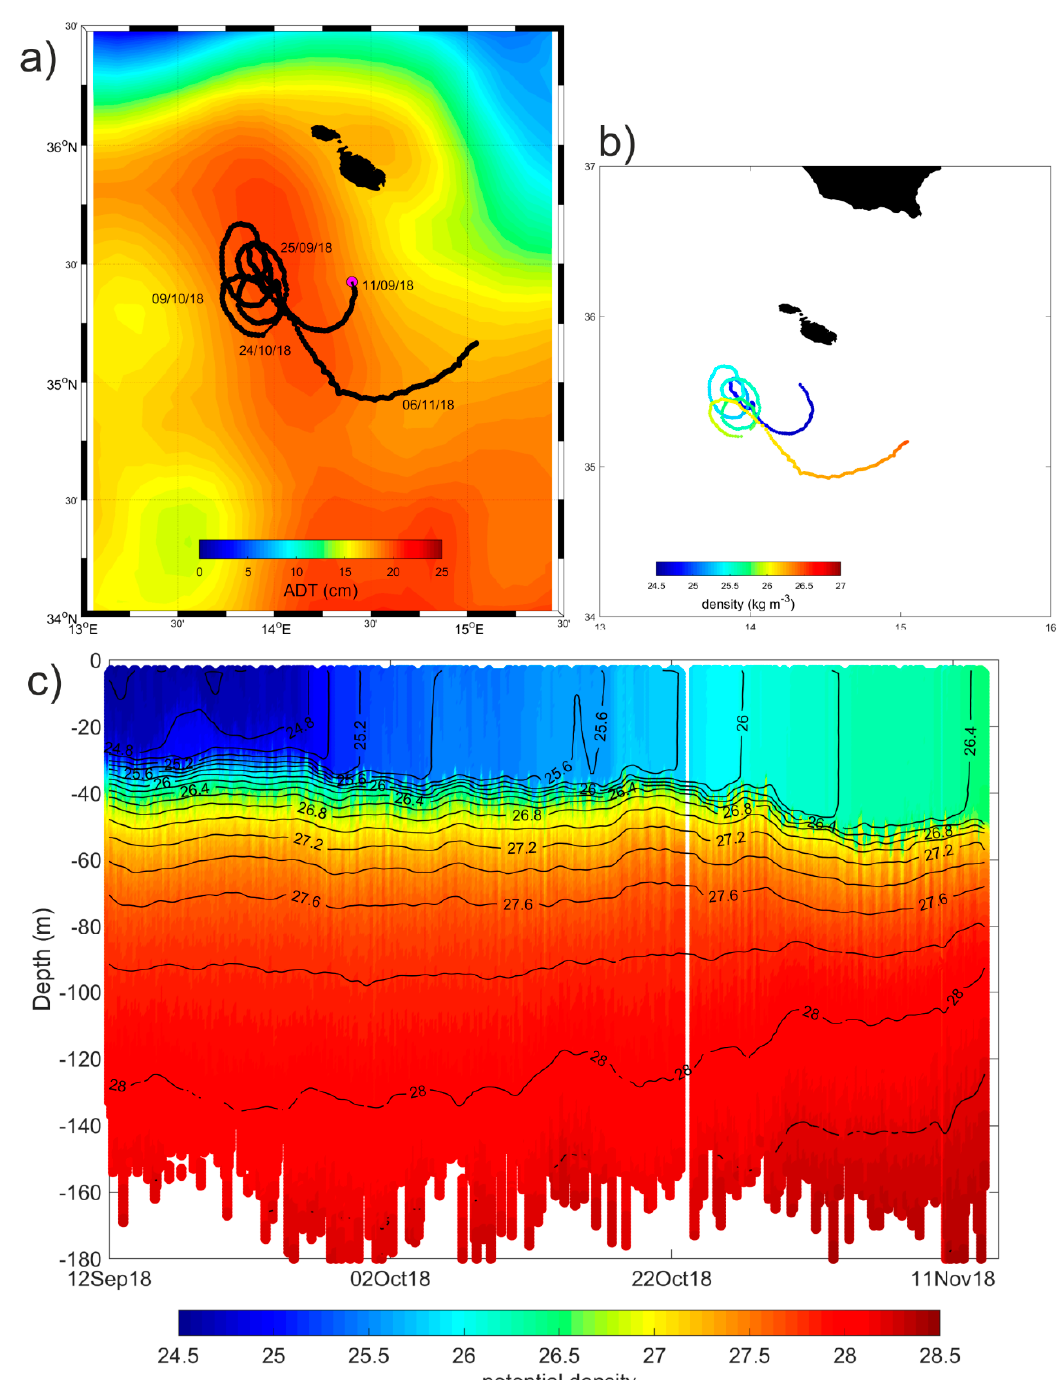
Figure 12. Map of the trajectory (black line) and profile positions (First profile: Magenta dot; Other profiles: Black dots) of the float WMO 6903242, superimposed on the mean map of the ADT (between 12 September 2018 and 11 November 2018) ( a ). Map of the potential density measured at 20 m depth ( b ) and contour diagram of the potential density versus depth and time ( c ).